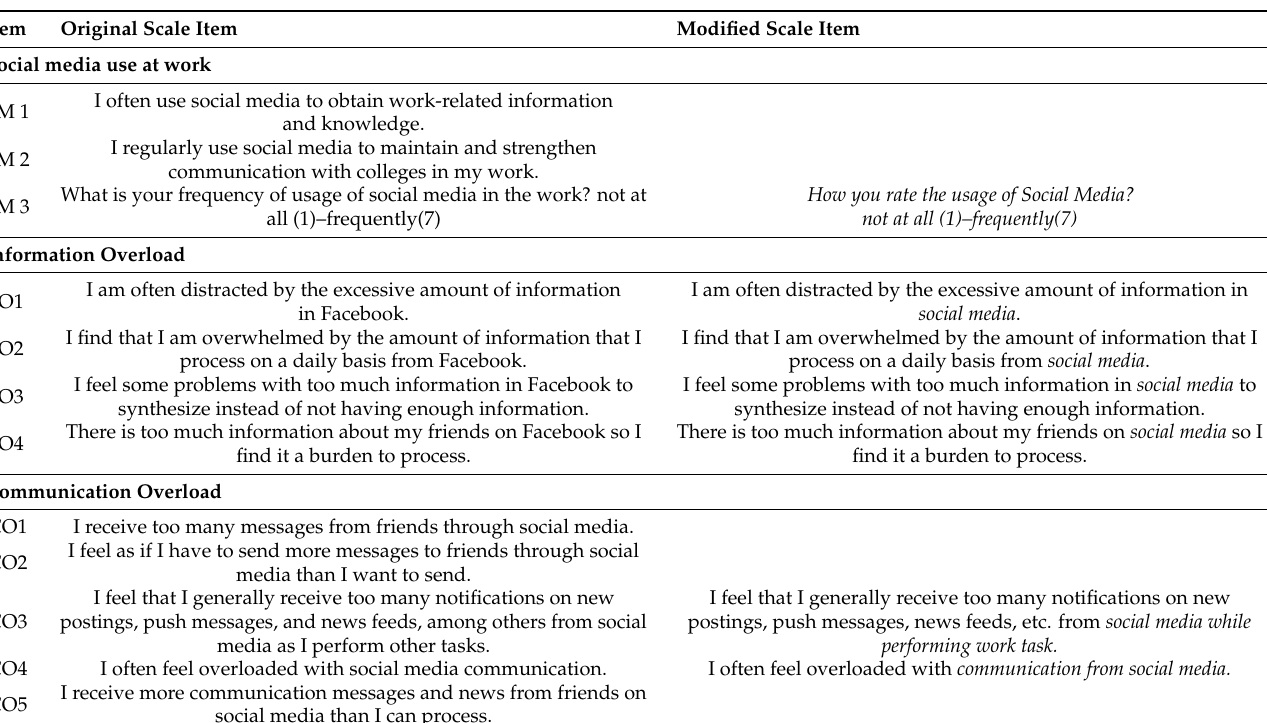
Table A1. Research